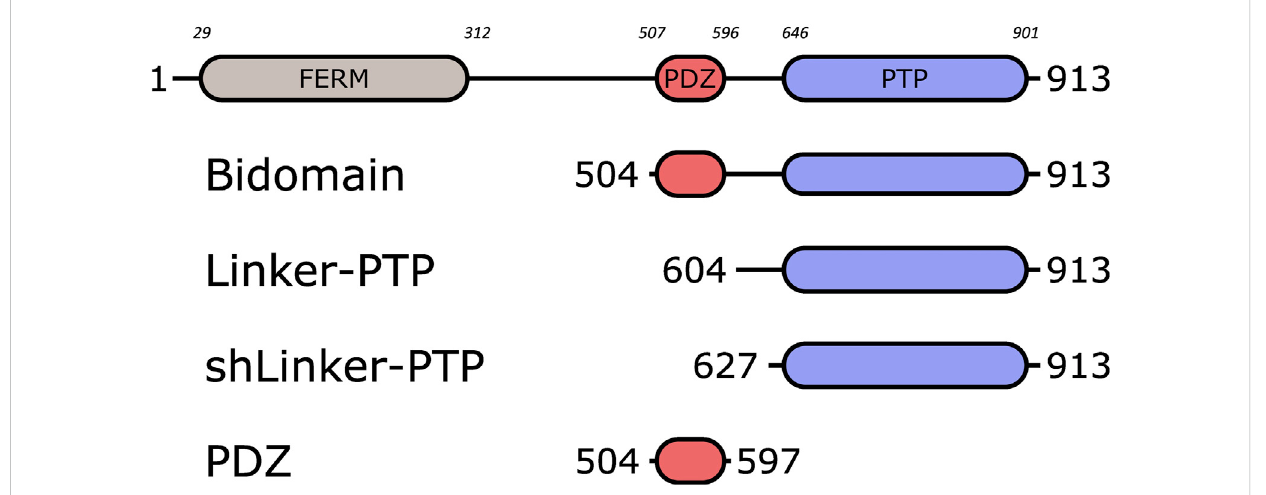
FIGURE 1 SchematicrepresentationofPTPN3andtheconstructs.TheFERM,PDZandPTPdomainsarerepresented.Theboundariesofthefull-lengthandthe constructs are shown. The numbers in italic above the schematic construct of full-length PTPN3 correspond to the boundary residues of each protein domain. Bidomain encompasses the PDZ and the PTP domains; Linker-PTP contains the linker and the PTP domain; shLinker-PTP contains a shorter linker and the PTP